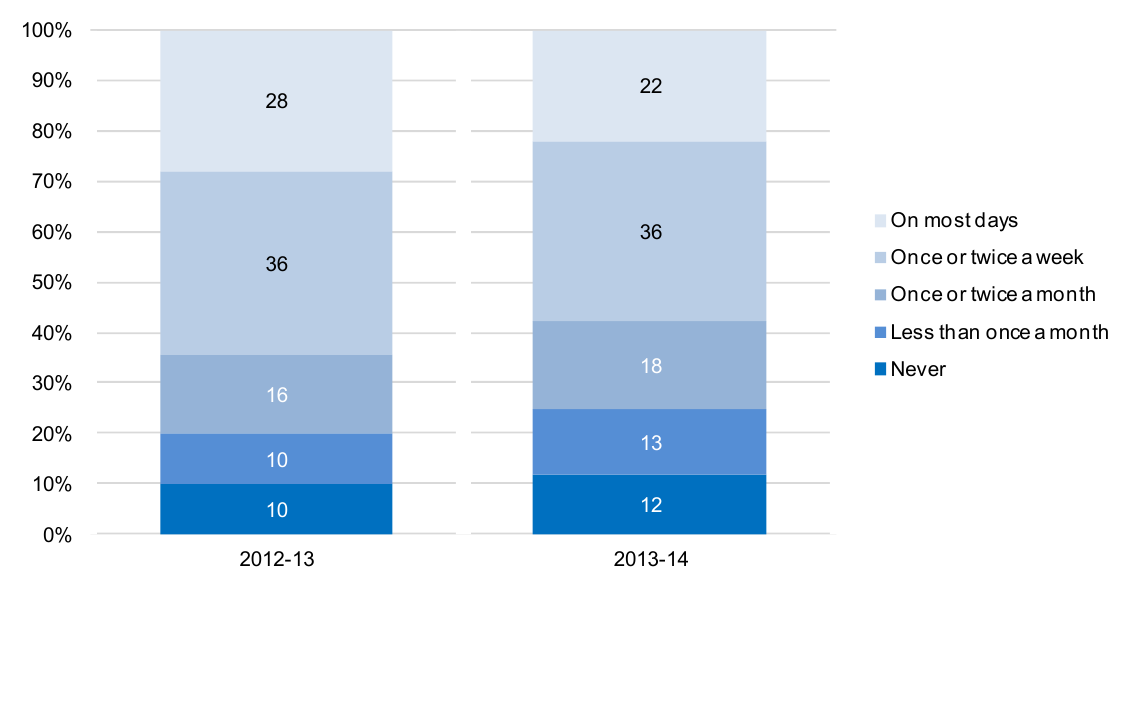
- Table 9: Whether people chat to their neighbours at least once a month by sex, age and ethnicity, October 2012 to 2013-14